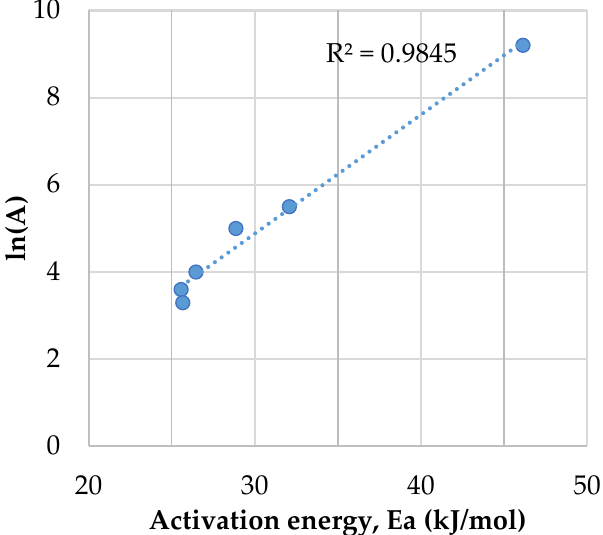
Figure 4. Relationship between the pre-exponential factor and activation energy for the RDF samples.